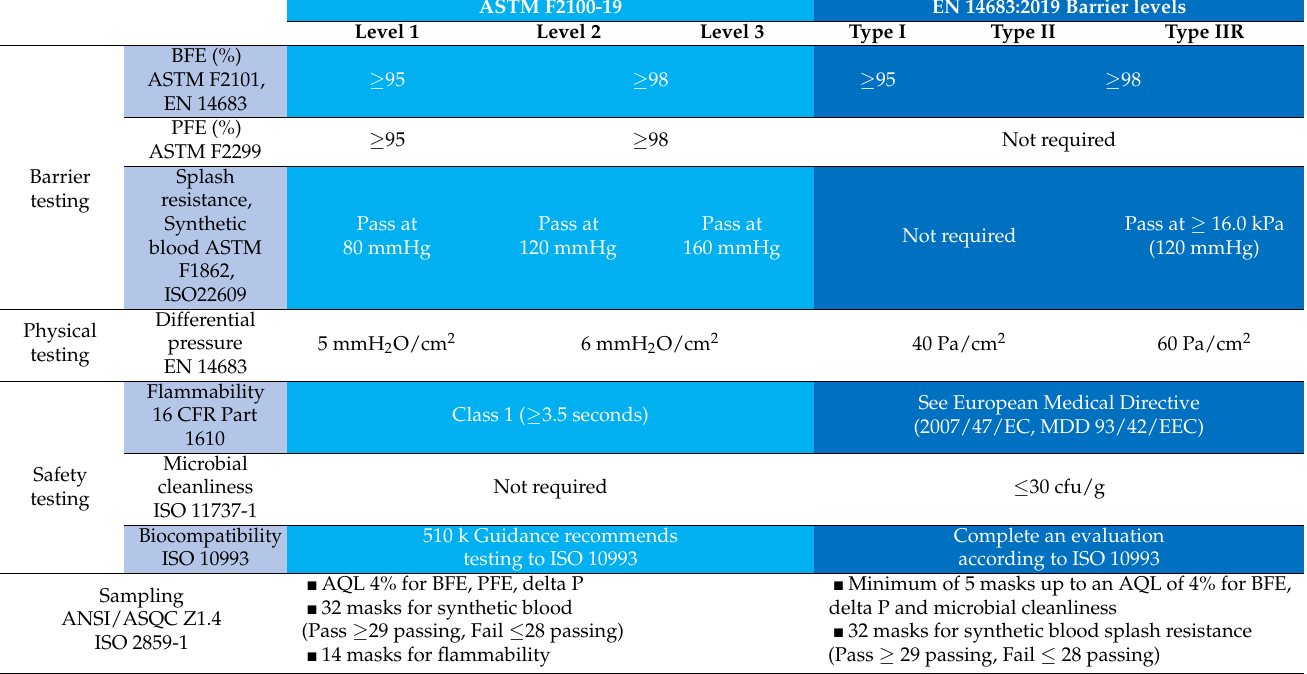
Table 2. Comparison of ASTM F2100-19 standard specification for performance of materials used in medical face masks (USA) and EN 14683:2019 medical face mask requirements and test